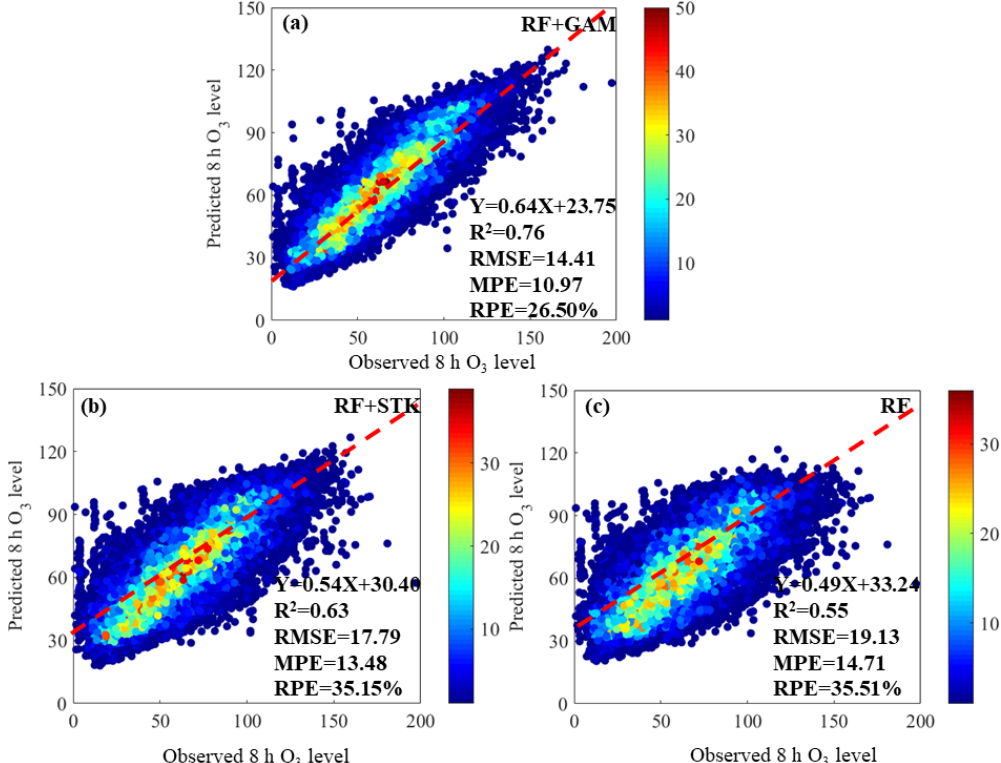
Figure 3. Density scatterplots of model fitting and cross-validation results at a daily level. Panels (a) , (b) , and (c) represent RF–GAM, RF– STK, and RF models, respectively. The red dotted line denotes the fitting linear-regression line. MPE, RMSE, and RPE are mean prediction error (µgm − 3 ), root-mean-square error (µgm − 3 ), and relative percentage error (%), respectively.